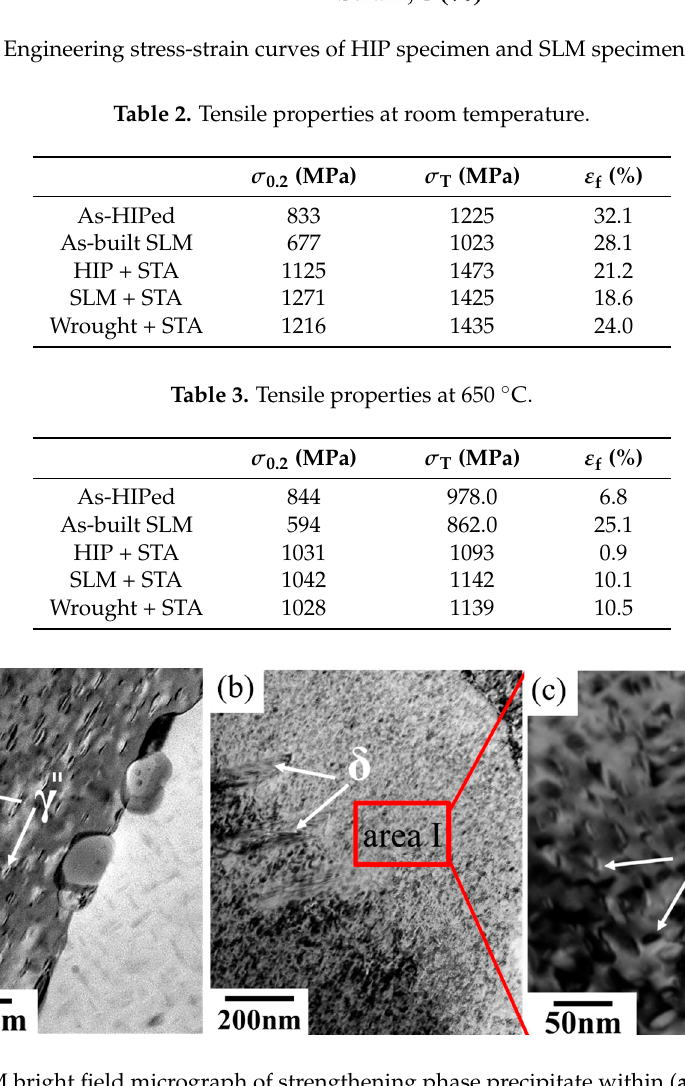
Figure 11. Fracture surfaces of ( a ) HIP + STA specimen and ( b ) SLM + STA specimen tested at room temperature; fracture surfaces of ( c ) HIP + STA specimen and ( d ) SLM + STA specimen tested at 650 °C. 3.4. Creep Properties The creep curves of heat-treated specimens at 650 °C and 550 MPa are shown in Figure 12. As for the SLM + STA specimen, the creep rupture life was approximately 140 h, while the HIP + STA specimen exhibited a rupture life of only 20 h. The fracture surface was observed along the grain boundaries covered with PPB in the HIP + STA specimen as shown in Figure 13a.